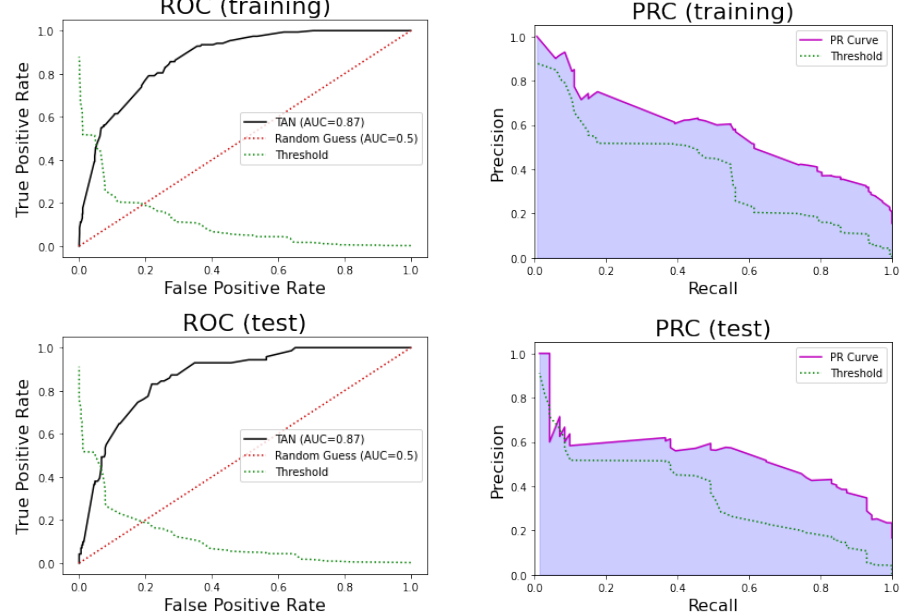
Figure 10. Top: Receiver Operating Curve (ROC) for the TAN model in training (left) and test (right) Figure 10. ( Top ) Receiver Operating Curve (ROC) for the TAN model in the training ( left ) and testing sets. Bottom: Precision-Recall Curve (PRC) in training (left) and test (right) sets. ( right ) sets. ( Bottom ) Precision-Recall Curve (PRC) in the training ( left ) and testing ( right )